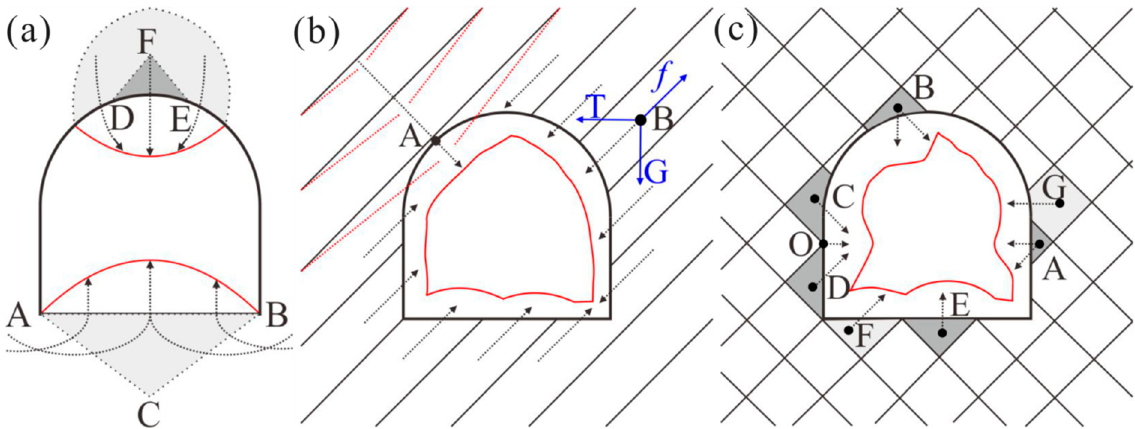
Figure 9. Schematic diagram of deformation modes. ( a ) Homogeneous surrounding rock; ( b ) Layered rock mass; ( c ) Rhom- boid rock mass.